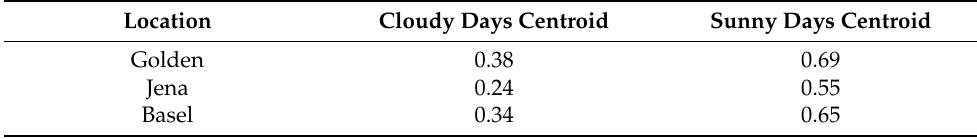
Table 4. The centroid values for sunny and cloudy days at the study